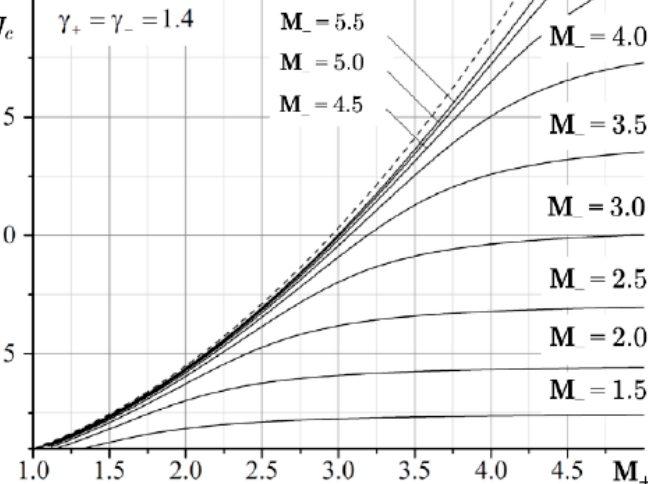
Figure 6. The values of the intensity J c of the incident shock for characteristic refraction. The dashed line shows the envelope corresponding to the case when the refracted shock has the maximum intensity J 2 = J m .